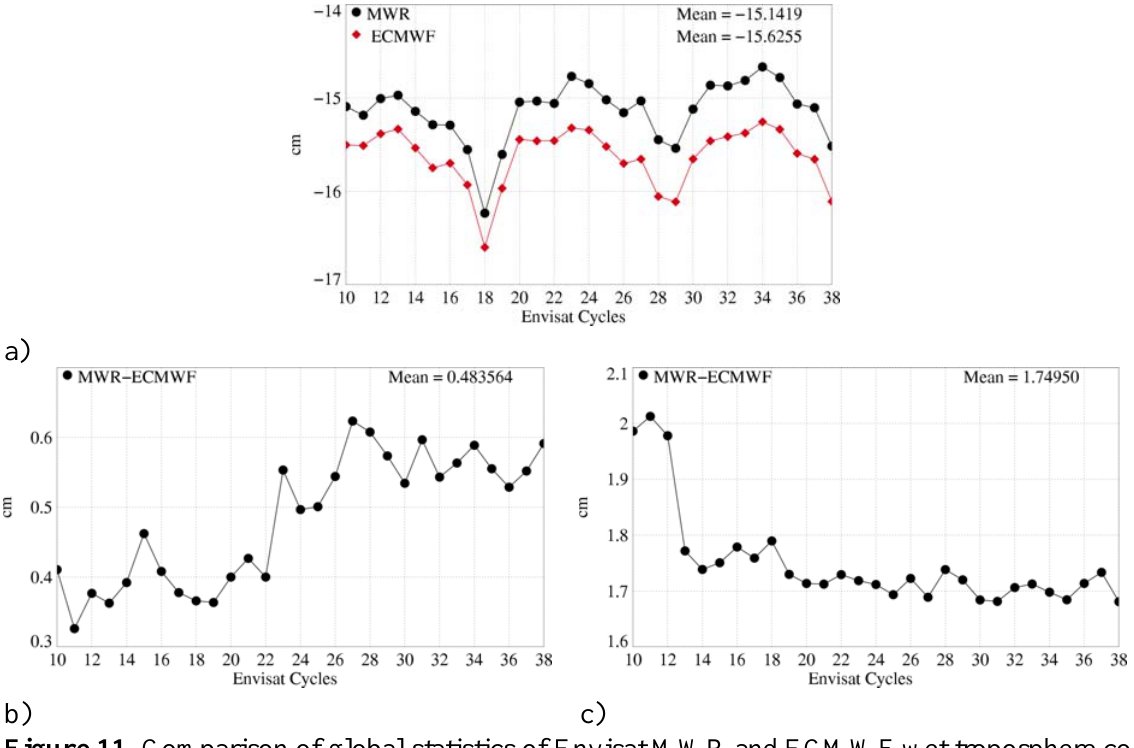
Figure 11. Comparison of global statistics of Envisat MWR and ECMWF wet troposphere corrections (cm). a) Cycle mean of MWR and ECMWF corrections. b) Mean of the differences. c) Standard deviation of the